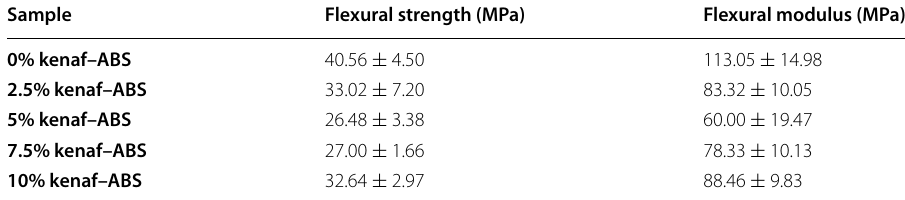
Table 4 Flexural strength and modulus for all samples Sample Flexural strength